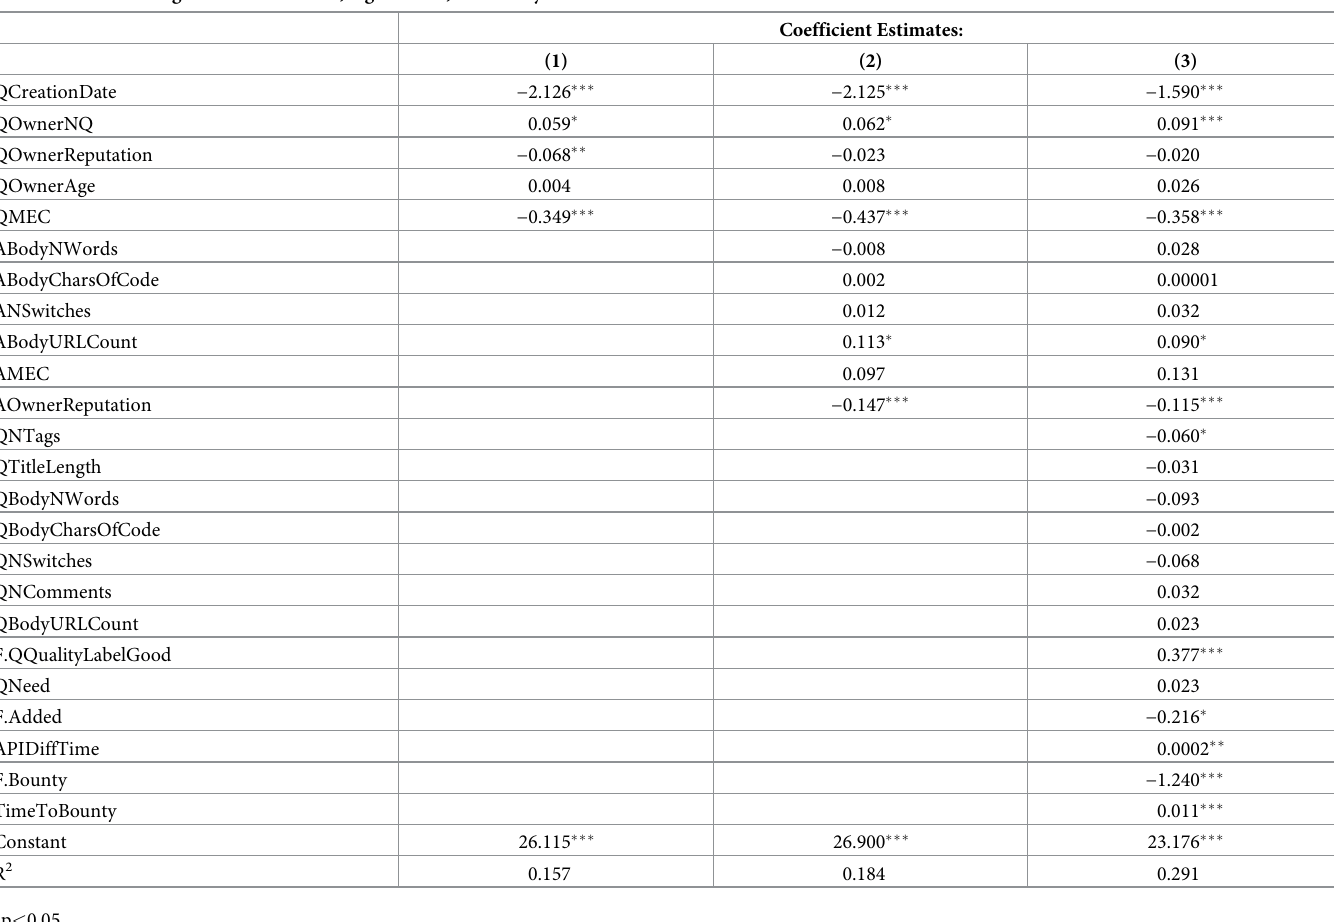
Table 5. Time to first good answer models, log minutes, after 2